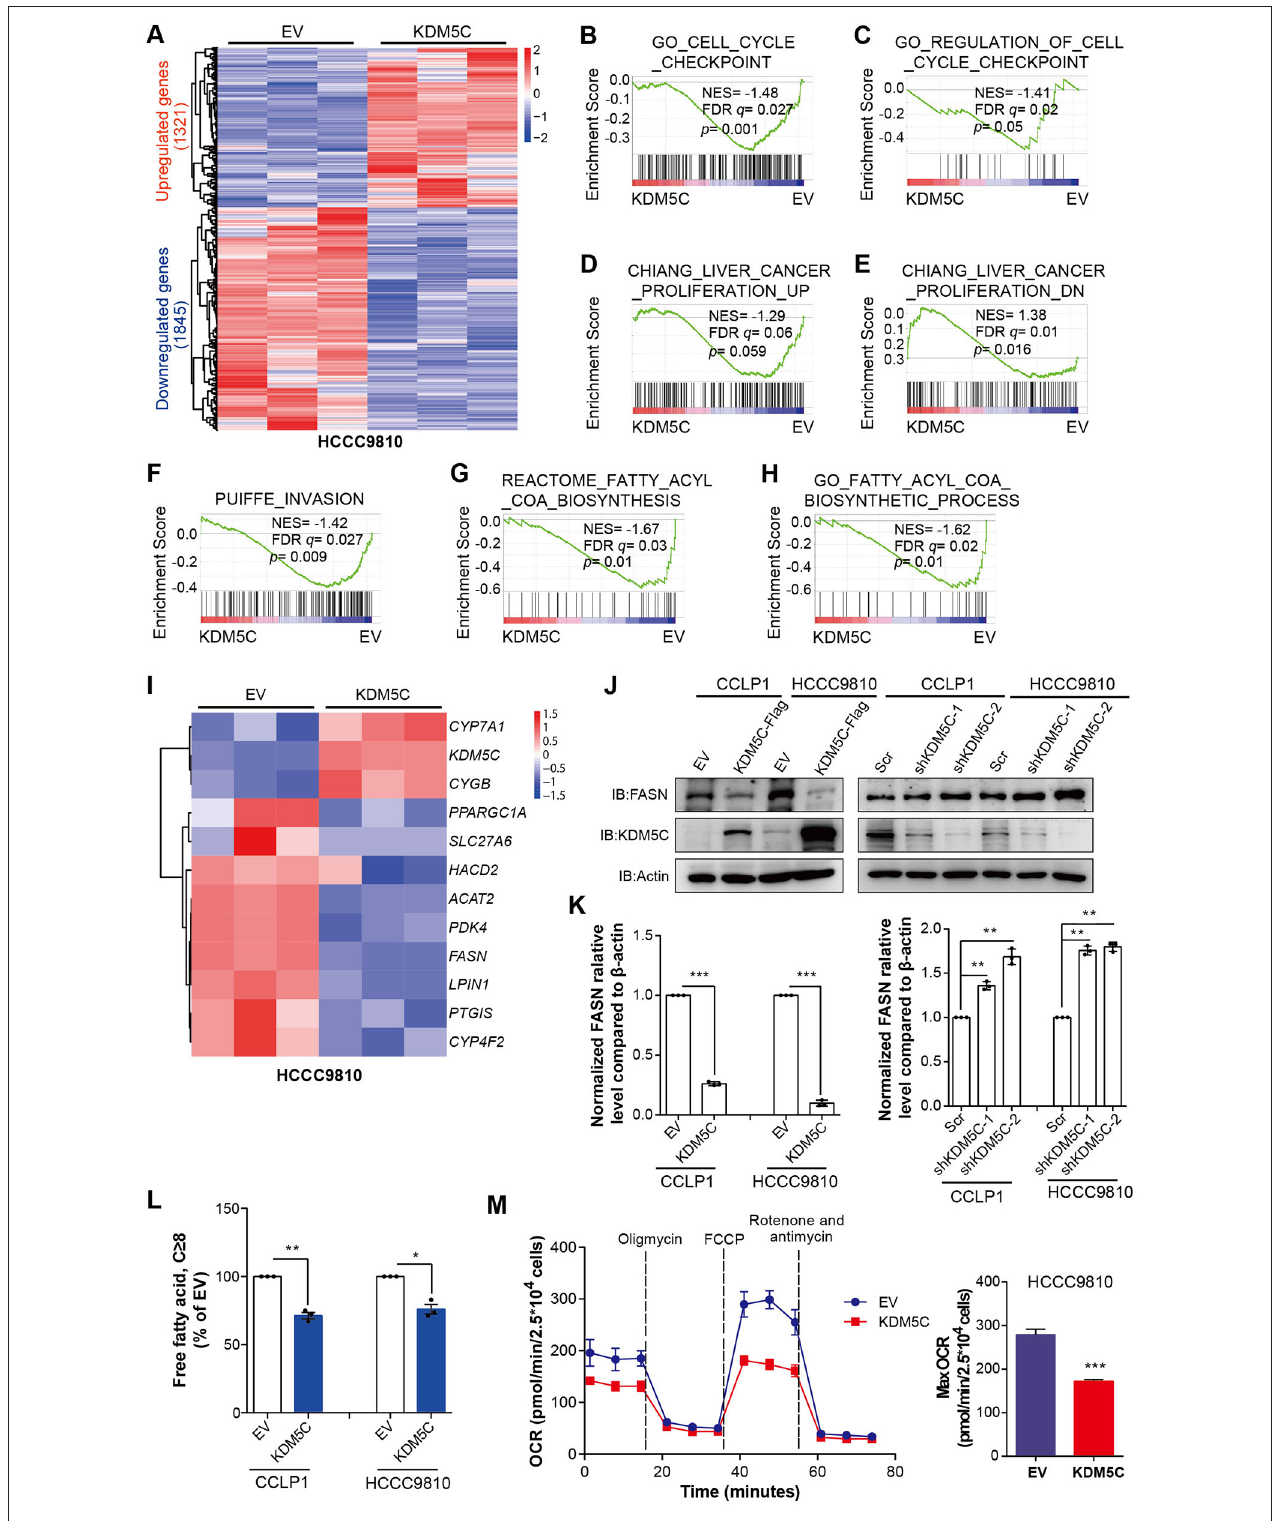
FIGURE 3 | KDM5C inhibits key regulators of cell proliferation, cell invasion and fatty acid metabolism. (A) Heatmap showing the differentially expressed genes between HCCC9810 cells stably transduced with control or KDM5C-expressing vector (fold change ≥ 1.5, p < 0.05). (B–H) GSEA of the expression profile of